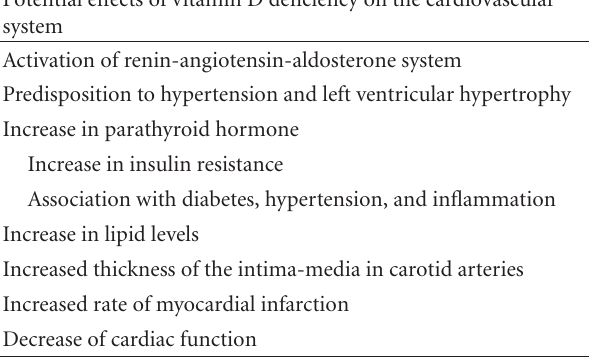
Potential e ff ects of vitamin D deficiency on the